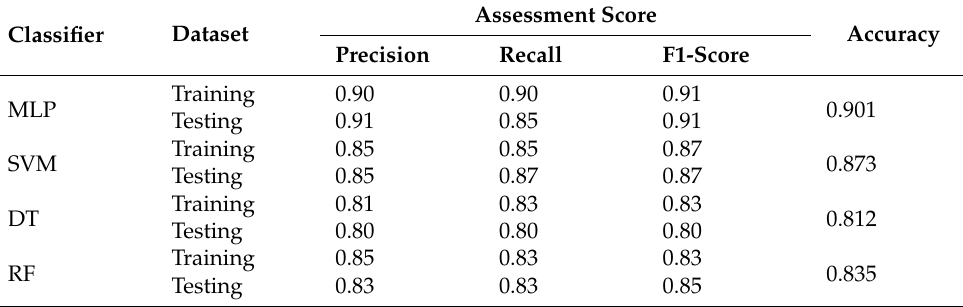
Table 5. The evaluation criteria estimate for predictive models.